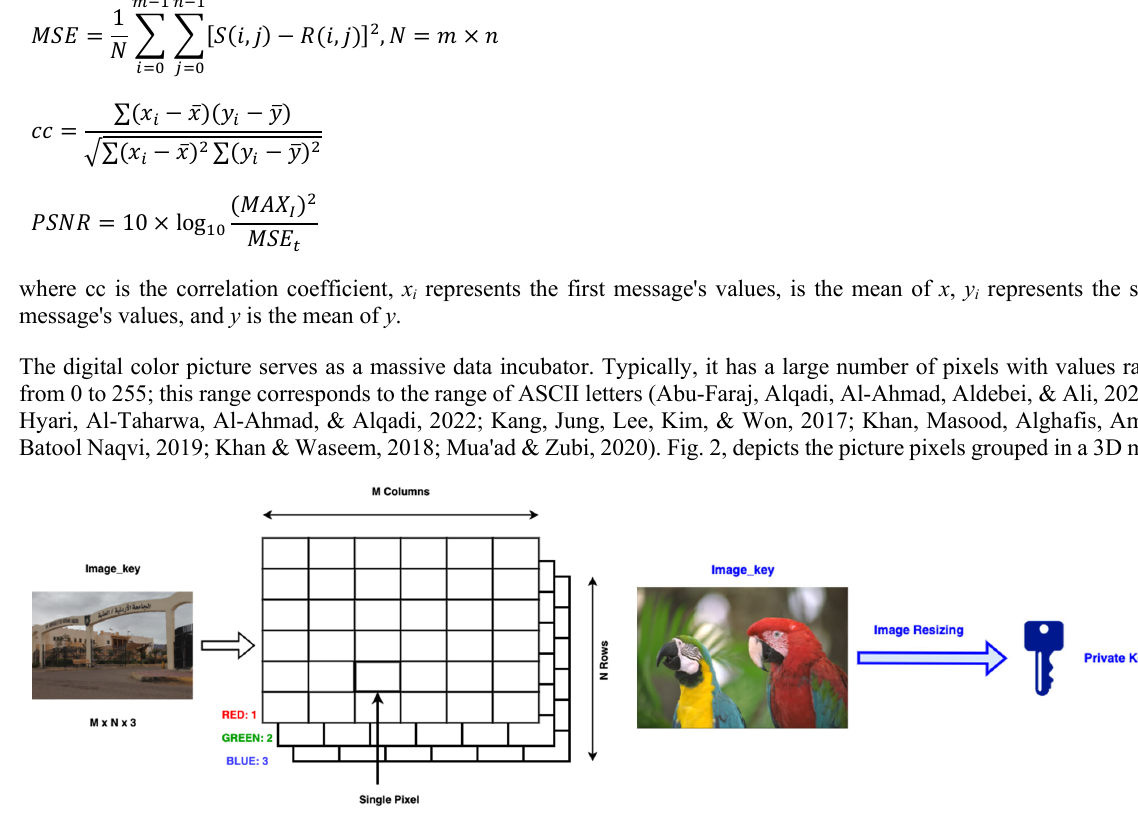
Fig. 2. Color image example Fig. 3. Resize formation of an image for PK